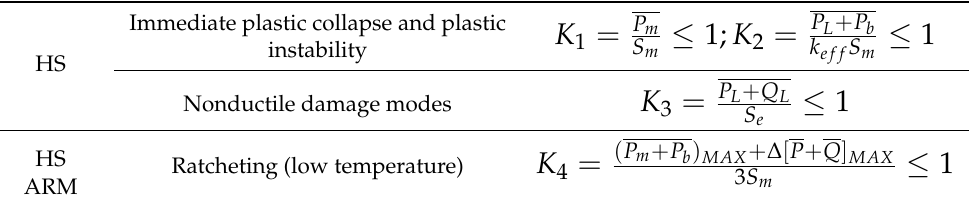
Table 3. Level A criteria to be met to protect heat sink (HS) and armour (ARM) against different damage